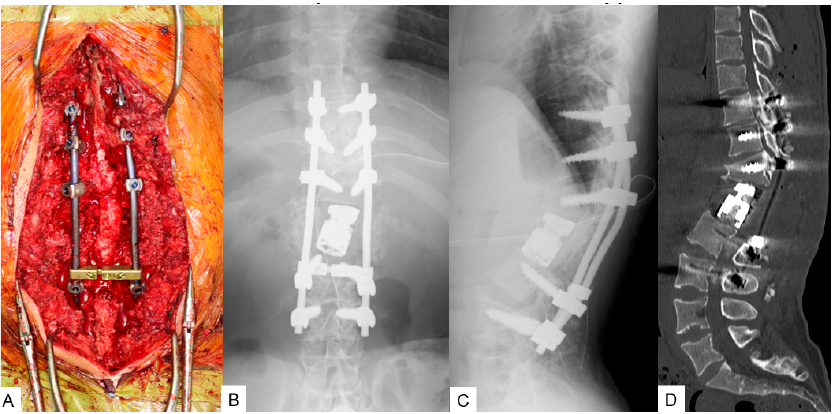
Figure 11. A 26-yearold man with achondroplasia; intra- and postoperative images. ( A ) Intraoperative images; ( B , C ) postoperative radiograms; ( D ) sagittal reconstruction CT.